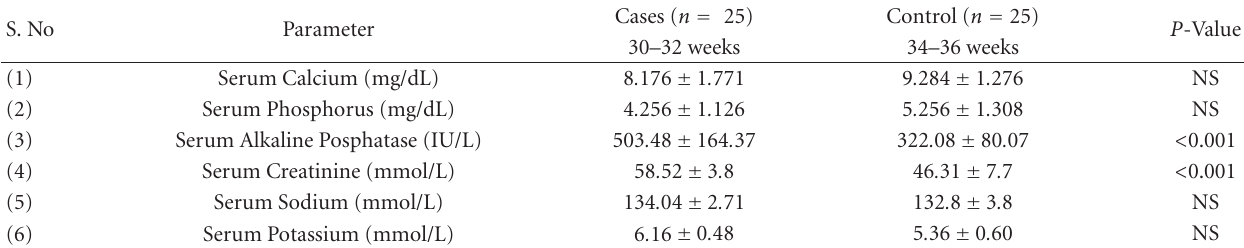
Table 2: Comparison of serum calcium, phosphorus, alkaline phosphatase, creatinine and electrolyte levels at 30–32 weeks and 34–36 weeks (Controls) of gestational age in preterm babies.